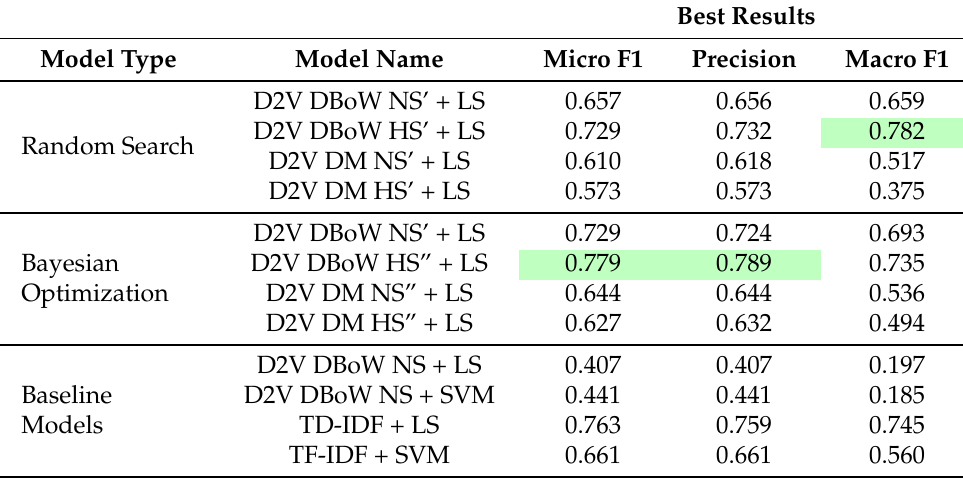
Table 7. Best predictions from the Precondition for Unsafe Act level.